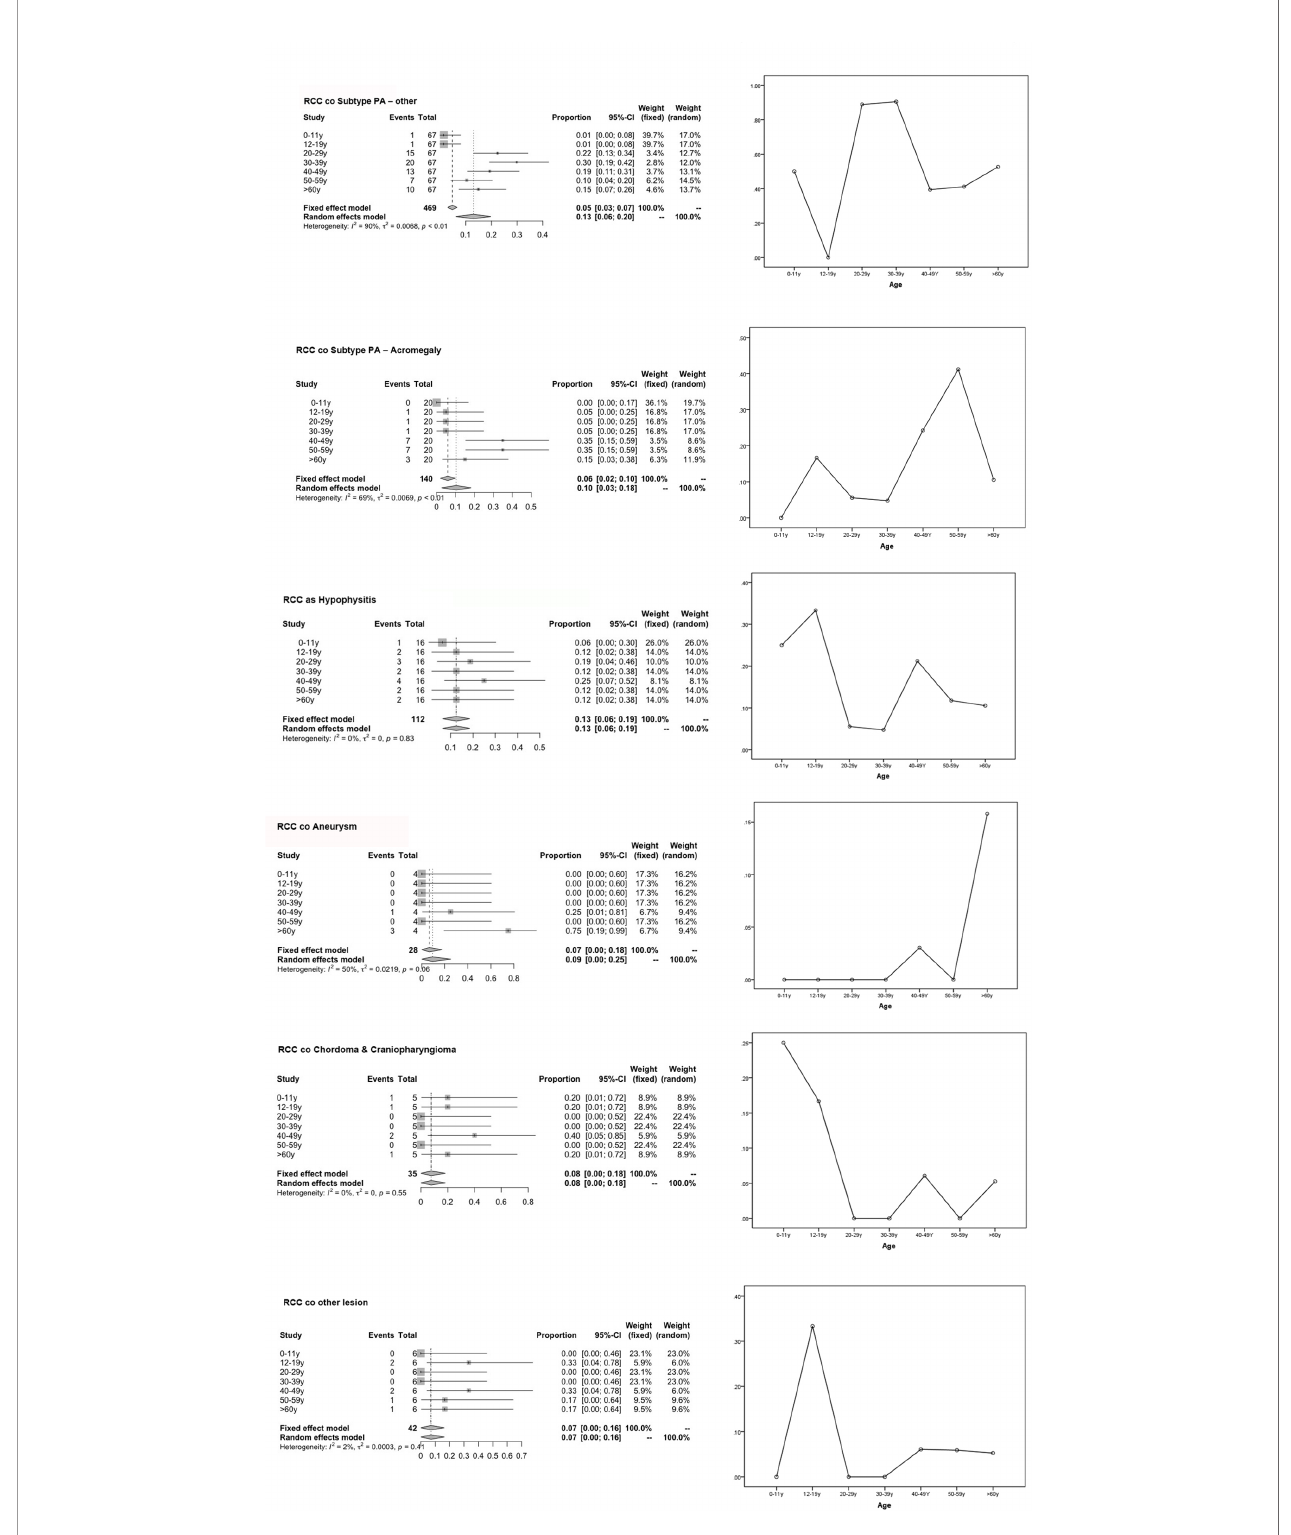
FIGURE 1 | Forest plot for the subgroup analysis of various population-based age groups and risk of age graph. This graph compares the risk of various subgroups (represented by combined RCC with sellar lesion) in each age group and the degree of merger risk within the age group (30 – 39 y, 50 – 59 y) calculated using our predictive